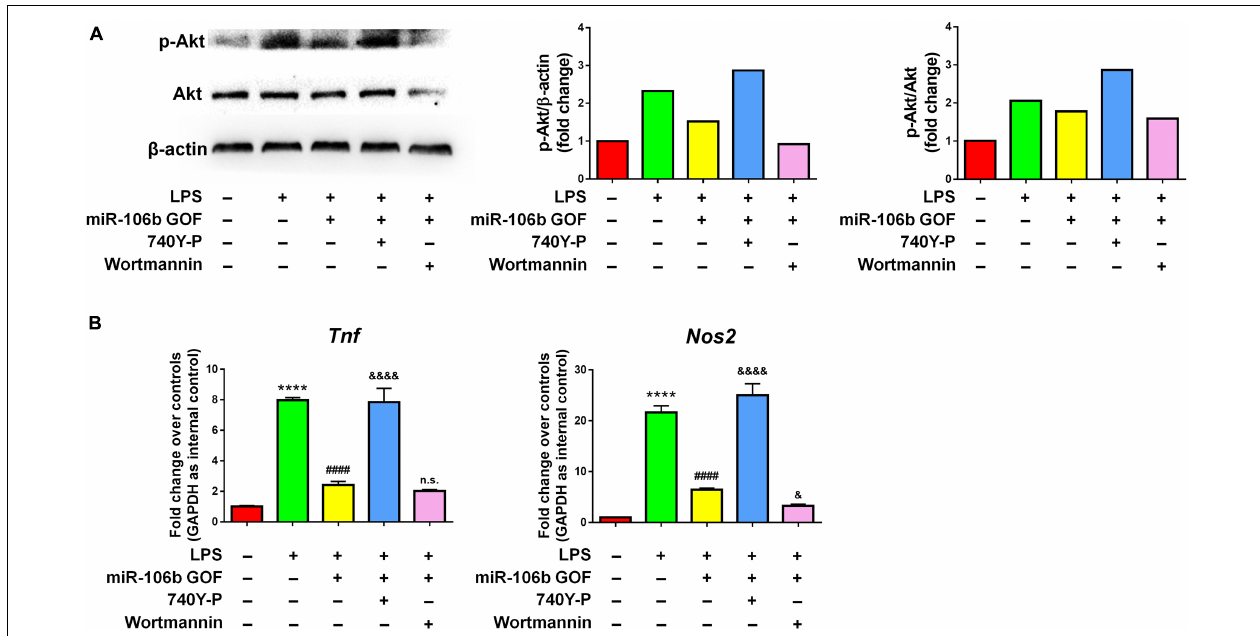
FIGURE 6 | The inhibitory effects of miR-106b on microglial activation are mediated by Pi3k/Akt pathway. Primary mouse microglia were stimulated by LPS, followed by the transfection of miR-106b mimics and the treatment of either 740Y-P or Wortmannin for 2 days. (A) The representative western blots showing the expression of p-Akt and Akt in (left). Densitometric quantifications were presented on the right. (B) The transcript levels of pro-inflammatory genes Tnf and Nos2 in microglia were determined by qRT-PCR. Data were represented as mean ± SD from three independent experiments. The symbol **** denotes p < 0.0001 in comparison with control group. The symbol #### denotes p < 0.0001 in comparison with LPS group. The symbols & and &&&& denote p < 0.05 and p < 0.0001, respectively, in comparison with LPS + miR-106b GOF group. GOF, gain-of-function. n.s. denotes